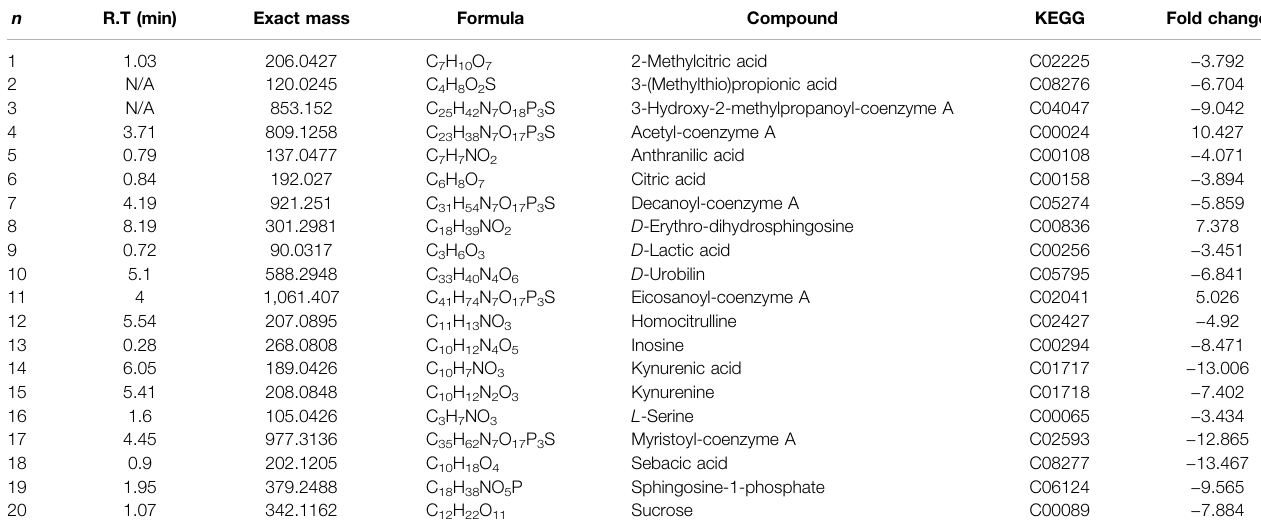
TABLE 3 | Characteristics of terminal metabolites in MRSA bio fi lms treated with 25 mg/ml